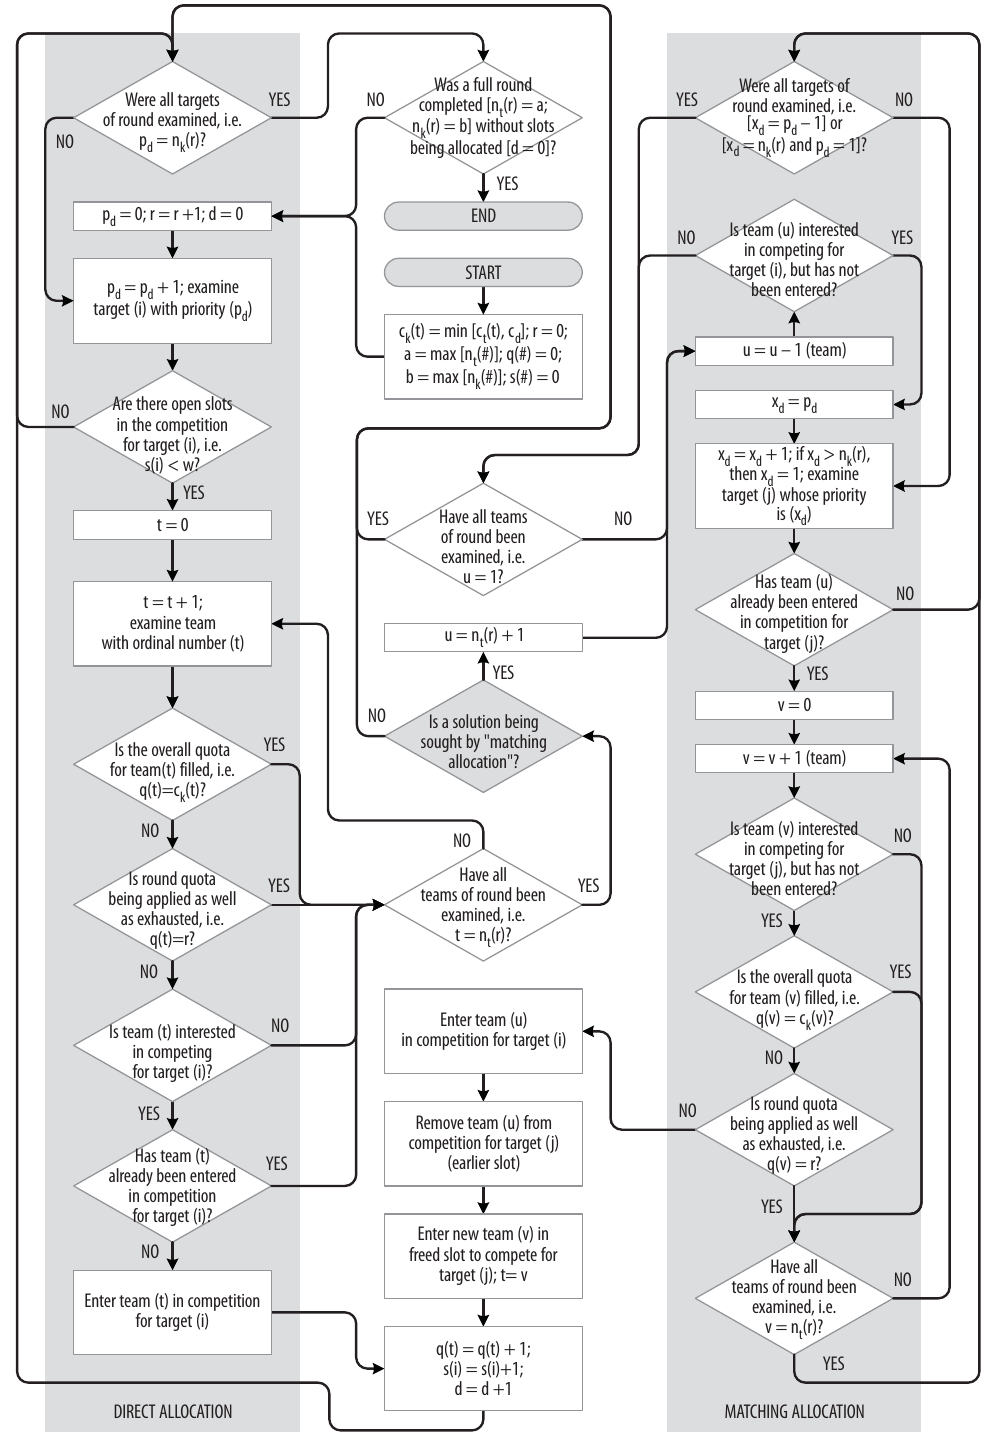
Fi gure 4. Allocation based on decision maker’s priorities (SDP) as a fl ow